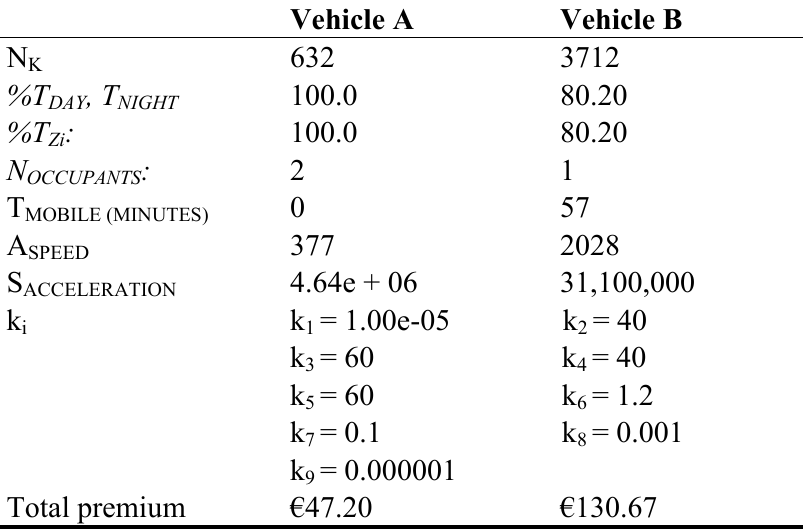
Table 3. Insurance premium